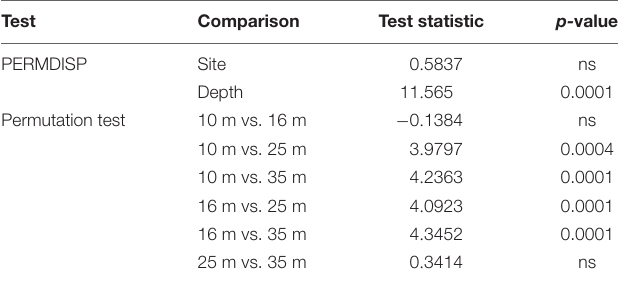
TABLE 2 | Test results for homogeneity of multivariate dispersions (PERMDISP) and pairwise permutation tests using the betadisper and permutest functions in vegan .